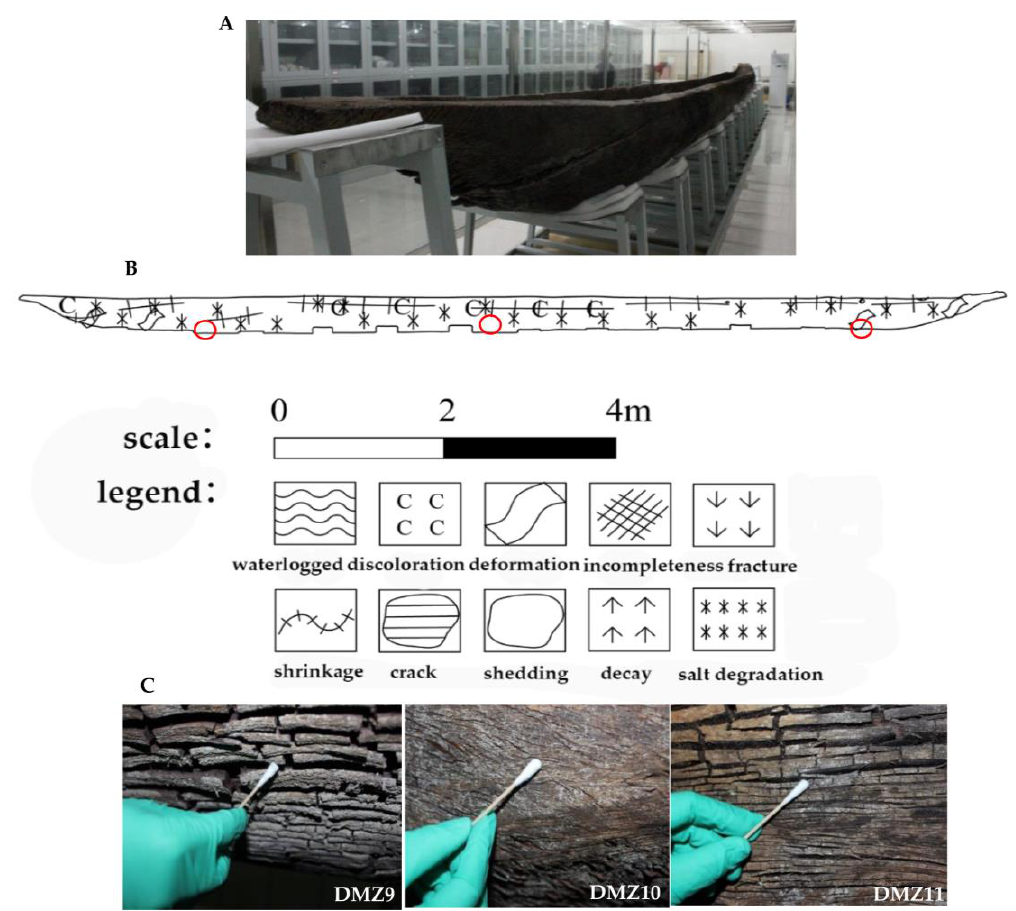
Figure 1. The overall preservation of the canoe and sample collection. The pirogue overall frame ( A ) and degradation situation ( B ). Sampling sites for microbiological analyses on the surface of the pirogue ( C ).